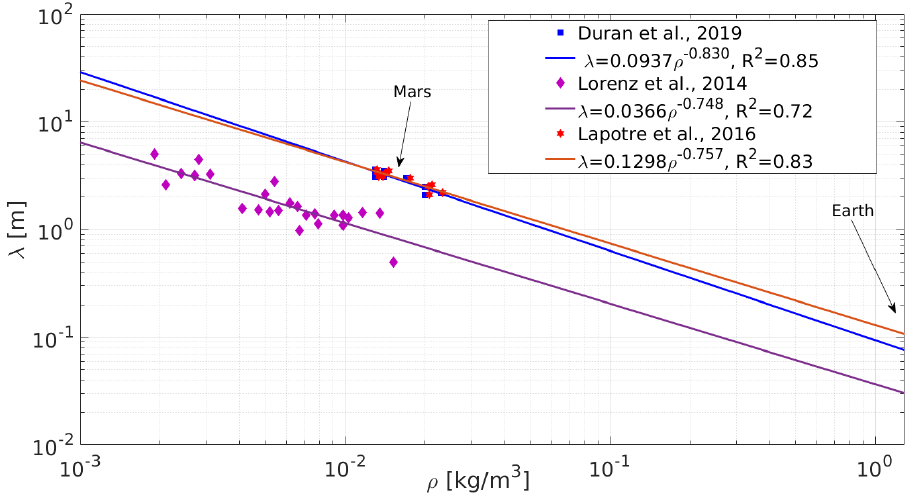
Figure 2. The scaling of the large Martian ripples’ wavelength with the atmospheric density based on previous published data [1,12,13]. The wavelength of the large ripples increases in lower atmospheric pressure conditions.